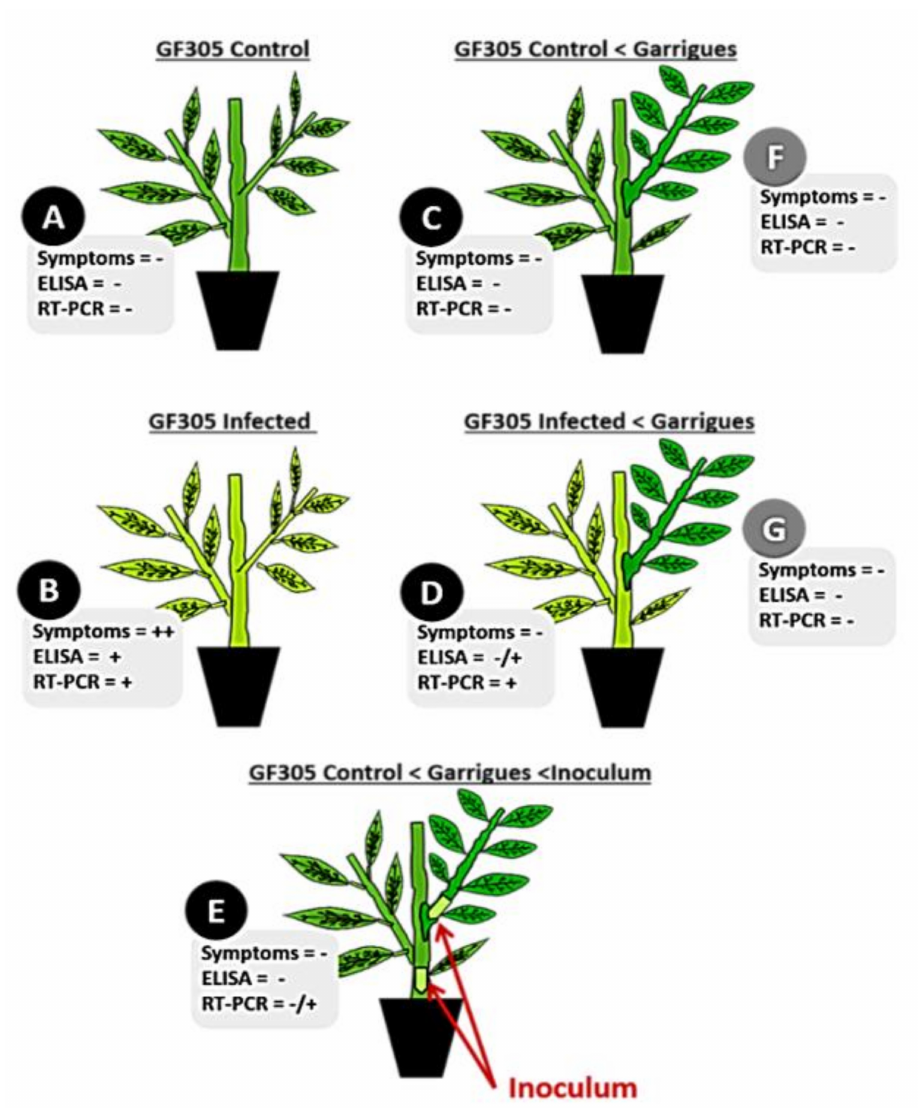
Figure 1. Schematic representation of the assayed treatments including symptoms, ELISA and RT-PCR: ( A ) control healthy “GF305” peach rootstocks; ( B ) Plum pox virus (PPV)-infected “GF305” rootstocks showing severe sharka symptoms; ( C ) healthy “GF305” peach rootstocks grafted with “Garrigues”; ( D ) PPV-infected “GF305” rootstocks showing sharka symptoms grafted with “Gar- rigues”; ( E ) healthy “GF305” peach rootstocks grafted with “Garrigues”, which were later inoculated with PPV at the end of the first cycle of evaluation. In addition, “Garrigues” almond samples grafted onto healthy ( F ) and PPV-inoculated “GF305” ( G ) rootstocks were included in the study. PPV was evaluated by symptom observation in leaf, ELISA-test and RT-PCR analysis. Presence of virus using these methodologies was indicated with + and absence with